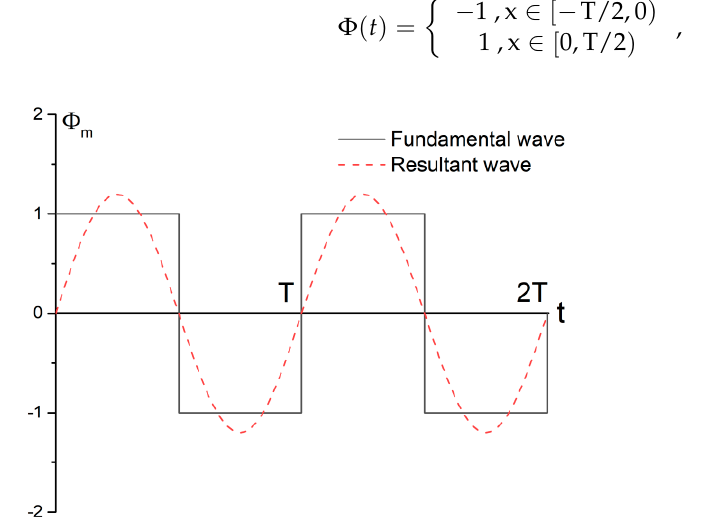
Figure 7. Rectangular wave shape.